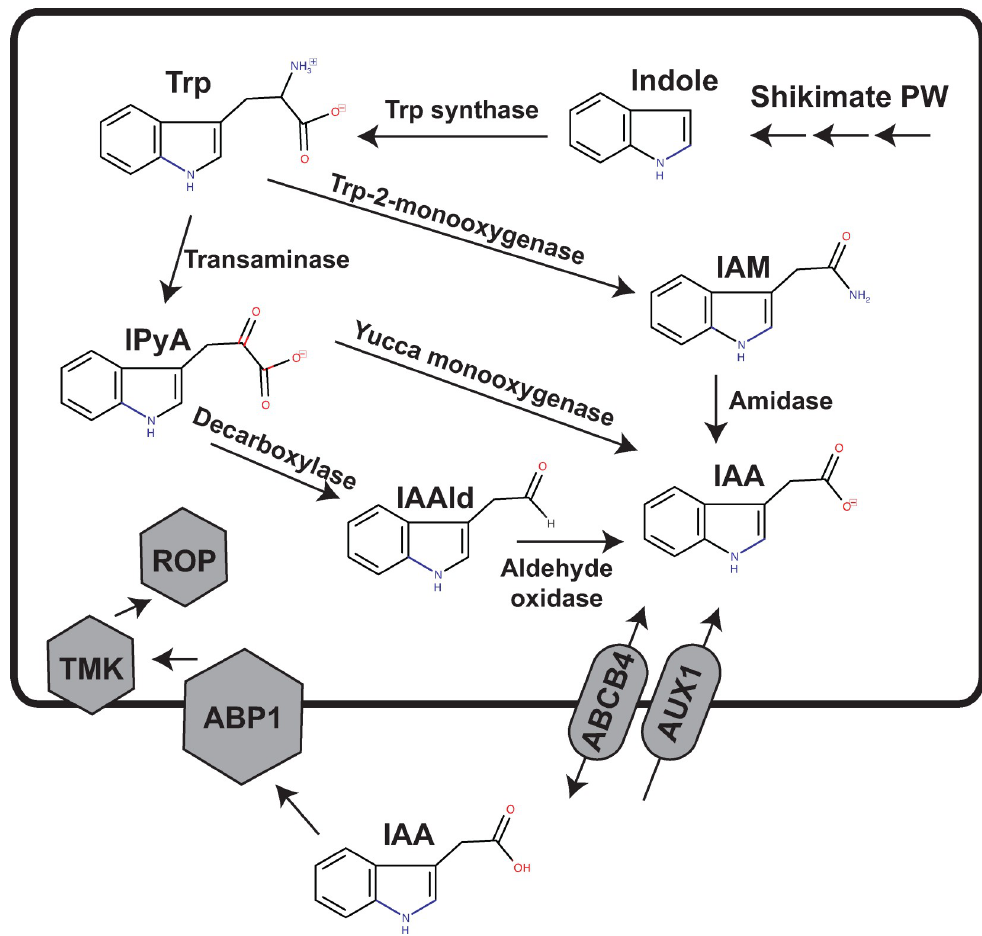
Fig 1. A model for auxin biosynthesis, transport, and signaling in Chlorella . Putative pathways of IAA biosynthesis in C . sorokiniana include (1.) the indole-3-pyruvic acid (IPyA) pathway: A tryptophan transaminase first converts Trp to IPyA and flavin monooxygenase (Yucca) converts IPyA to indole-3-acetic acid (IAA); (2.) The indole-3-acetamide (IAM) pathway: Primarily a pathway in phytopathogenic bacteria, IAM has been detected in all plants tested; furthermore, plants encode an amidase that converts IAM to IAA; (3.) The indole-3-acetaldehyde (IAAld) pathway. In the IAAld pathway, IPyA is converted to IAAld by a decarboxylase, and indole-3-acetaldehyde oxidase converts IAAld to IAA. Efflux and import functions are associated with the presence of specific transporters and the ABP1 receptor and associated downstream signaling components are present, as specified in Table